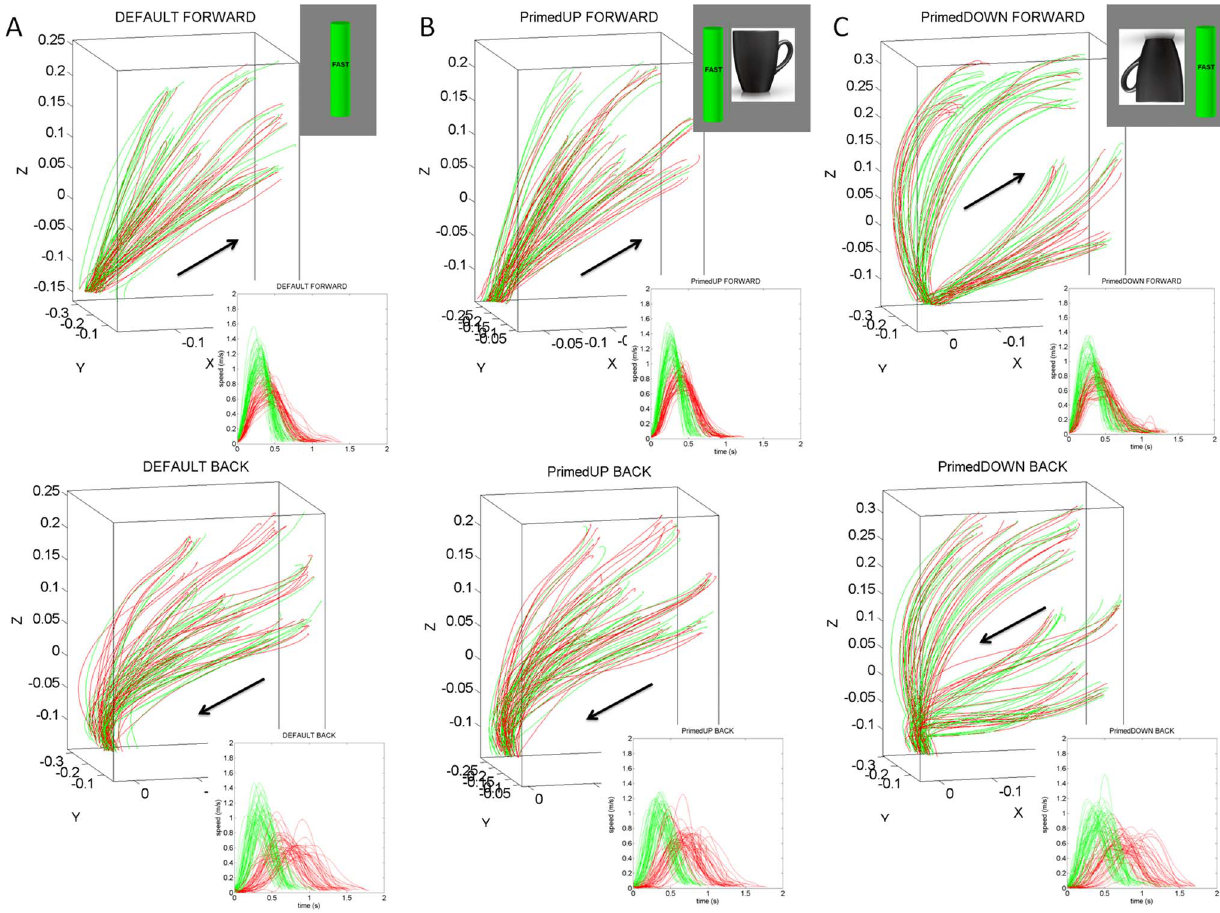
Figure 5. Effects of priming on the movement trajectories at the wrist in typical NC participant using two different levels of speeds randomly cued. (A) DEFAULT forward motion trajectories with corresponding speed profiles for slow (red) and fast (green) cases. Inset shows the actual stimuli on the screen priming the subject to match the orientation of the rod on the screen (vertical in this case) with the hand-held rod. Top are the forward paths and bottom are the retracting motions. (B) Primed-UP cases evoked similar final orientations as the DEFAULT condition. The inset shows the priming cup with handle next to the original rod. This figure is made from the right hand data and right hand stimuli for a right- handed person. (C) The primed-DOWN condition changed the trajectories in both the forward and retracting cases. The inset shows the priming condition where the arm and hand underwent complex rotations. The instruction was to match the orientation of the rod on the screen as if the hand were to gasp the handle of the cup to drink from it. Notice the dramatic differences in trajectories for all target positions. NCs maintain the instructed speed throughout the continuous forward-and-back loop.